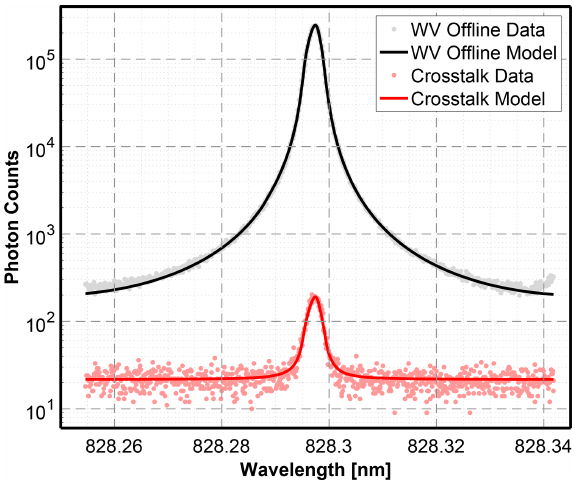
Figure 10. Etalon profile from a receiver scan of MPD02 from 22 September 2020. The measured data points are shown along with a model fit (solid line) to the data. The model reflects the range of angles – up to 3mrad as expected from the multimode fiber and re- ceiver optics’ combined output before the etalon. The scan indicated the etalon bandpass is 1.3GHz (3pm) FWHM, and the isolation be- tween online and offline seed lasers is 31.6dB. The incident angle weights are nonzero between 0 and 3mrad with a peak at